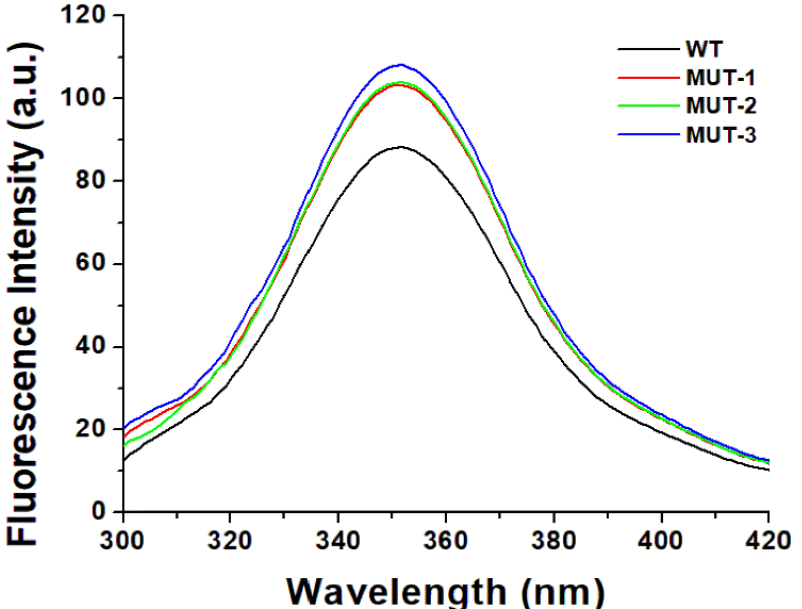
Figure 4. Intrinsic tryptophan fluorescent graph for wild type and mutant HIV-1 PR variants.